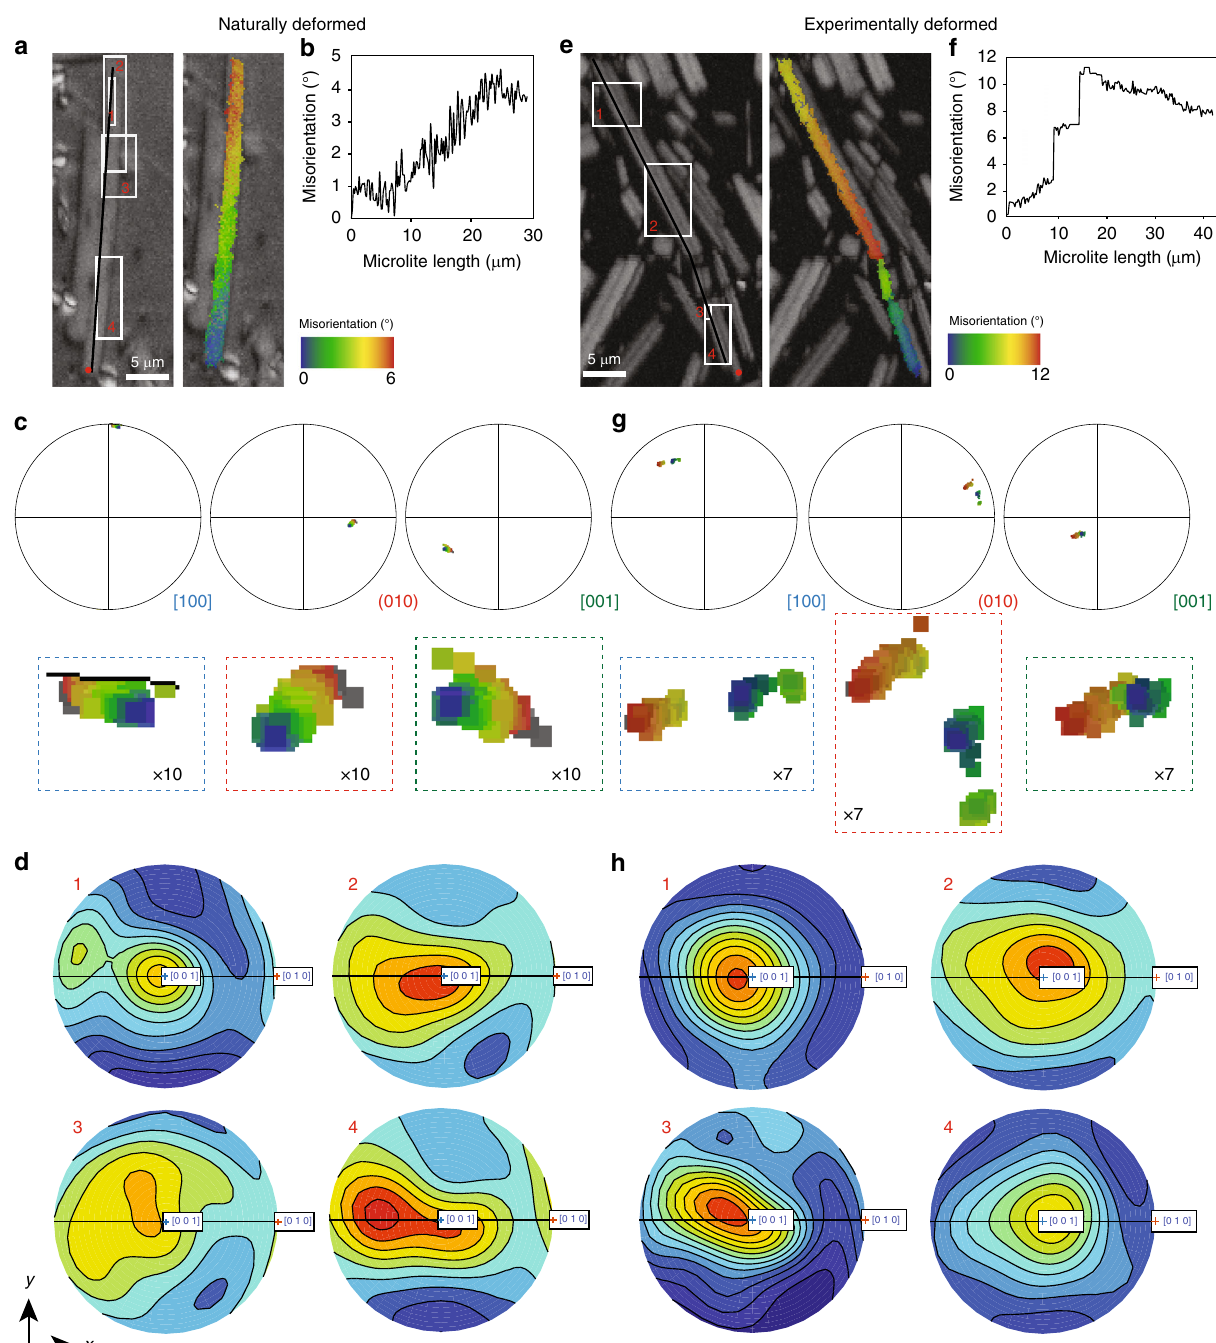
Fig. 4 Crystal-plasticity in plagioclase. a Band contrast image with location of WBV analysis areas 1 – 4 misorientation transect line and texture component map showing crystallographic misorientation in a plagioclase microlite (example from COLB2 starting material) — colour varies due to distortion in the crystal lattice from a reference point, according to the scale given (here 6 o ), with progressive rotation indicating crystal plasticity resulting from dislocation; b the misorientation pro fi le along the black line on the crystal in a (from the orange dot in the image at 0,0 on the plot), showing > 4 o misorientation across the crystal; c pole fi gures [100] (010) [001] (lower hemisphere) show the deformation of the same microlite (with the same colouring as in a ) partitioned in each crystallographic axis. d Slip systems using the weighted Burgers vector (WBV) method devised by Wheeler et al. 76 , which shows the Burgers vectors of dislocations of the areas marked 1 – 4 in a . The K vector components in ( μ m) − 2 for box 1 in a are: a = 6.21, b = − 1.83 and c = 16.65; e as a , for a broken microlite (example from COLB2 28 MPa, 30% strain sample) showing crystal plasticity within the three distinct segments, with the compression direction vertical in the image; f as b for the same crystal in e — the misorientation within the intact segments is gradual, but is punctuated by abrupt misorientation increases across the fractures in the microlites; g pole fi gures [100] (010) [001] (lower hemisphere) show the deformation of the microlite in e (with the same colouring), with each of the three fragments plotting as isolated patches that spread along the same axes, highlighting that the fragments have been displaced within the sample following fracture; h slip systems of boxes 1 – 4 in e , using the WBV method, which shows the Burgers vectors of dislocations. The K vector components in ( μ m) − 2 for box 3 in e are: a = 0.13, b = − 7.10 and c = −